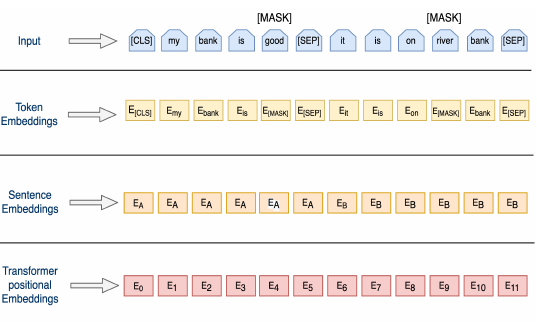
Figure 4. Here we can see the typical breakdown of the pair of sentences into three embeddings, Token embedding, Sentence embedding, and Transformer positional Embedding. The exciting thing about BERT is that it can differentiate between the same word ’bank’ used in different contexts in two separate